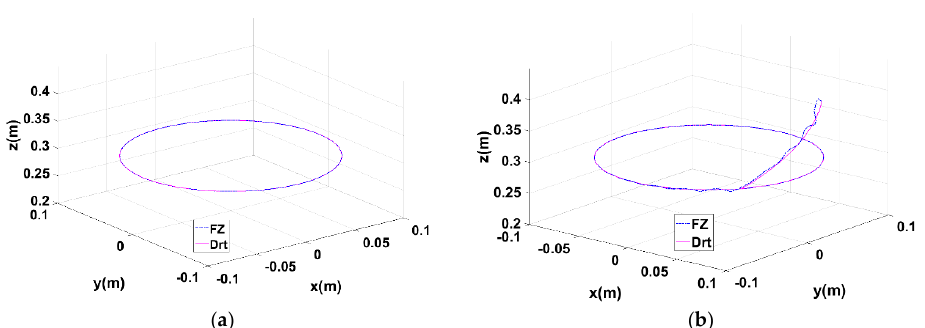
Figure 15. The trajectory of the cutting point with respect to the operational frame. (a)- when there is no initial deviation; (b)- there is initial deviation.